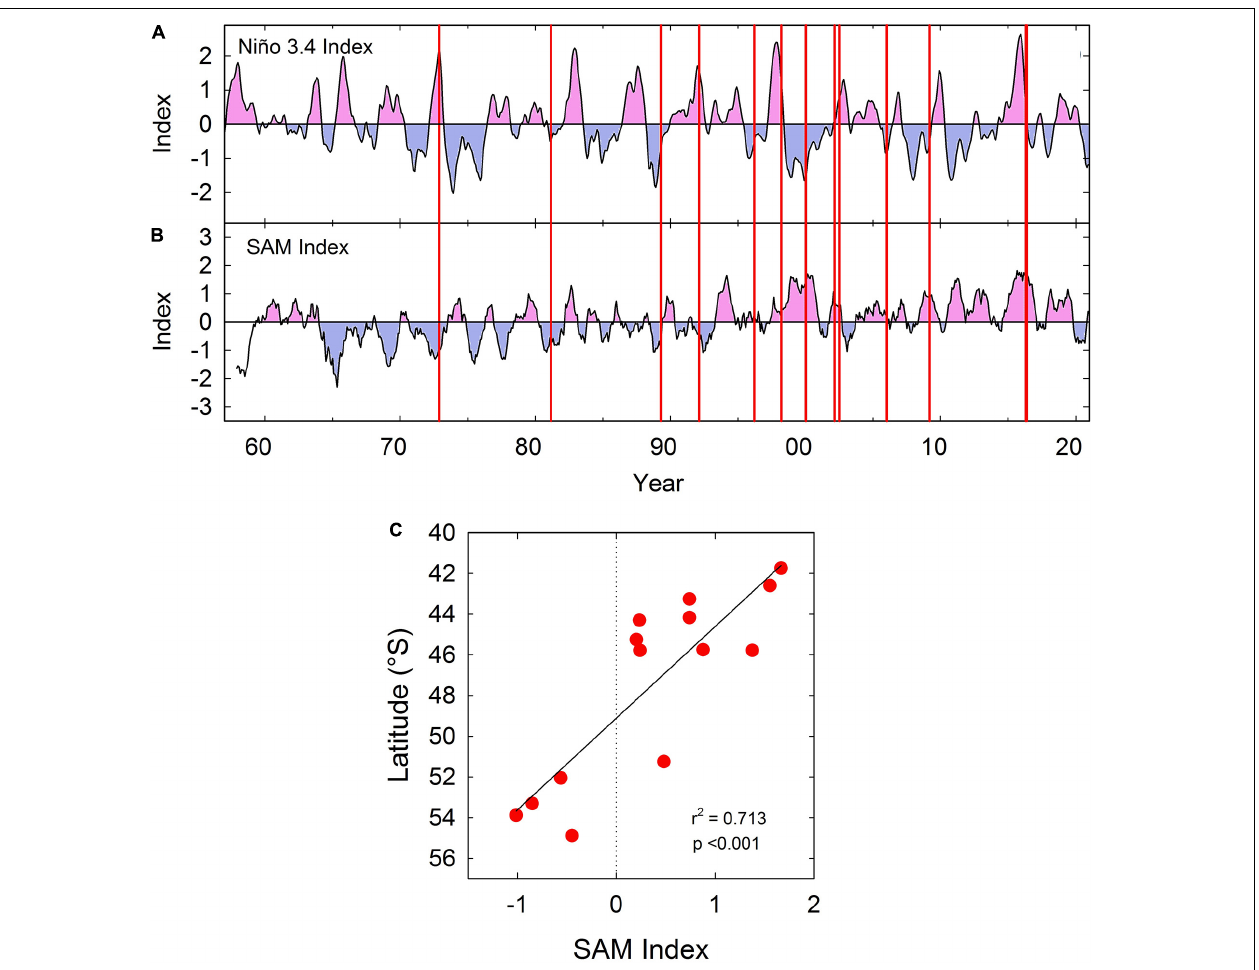
FIGURE 8 | (A) Variation in monthly Niño 3.4 index between 1957 and 2020 (3-month running mean). Data provided by Climate Prediction Center, NOAA (http://www.cpc.ncep.noaa.gov/data/indices/oni.ascii.txt). Positive anomalies shaded in pink, negative shaded in blue. Vertical red lines indicate the approximate time of peak events caused by A. catenella in Patagonian and Fuegian coastal waters (taken from Table 1 ). (B) Variation in monthly Southern Annular Mode (SAM) index (12-month trailing mean) between 1957 and 2020. Data provided by (http://www.nerc-bas.ac.uk/icd/gjma/sam.html). Vertical red lines as described in (A) . (C) Significant relationship between monthly SAM index shown in (B) and latitude of peak events caused by A. catenella (taken from Table 1 ). Linear regression is also significant with a 9 month ( r 2 = 0.601, p < 0.01) or a 6 month ( r 2 = 0.428, p < 0.05) trailing mean for SAM index, but is not significant with a 3-month trailing mean, or with the raw monthly